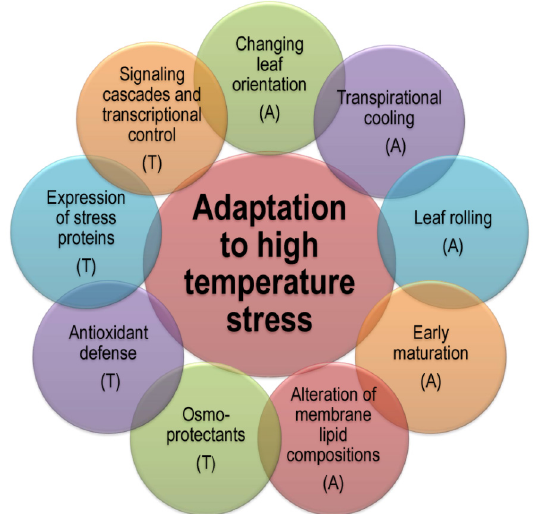
Figure 4. Different adaptation mechanisms of plants to high temperature. A: Avoidance, T: